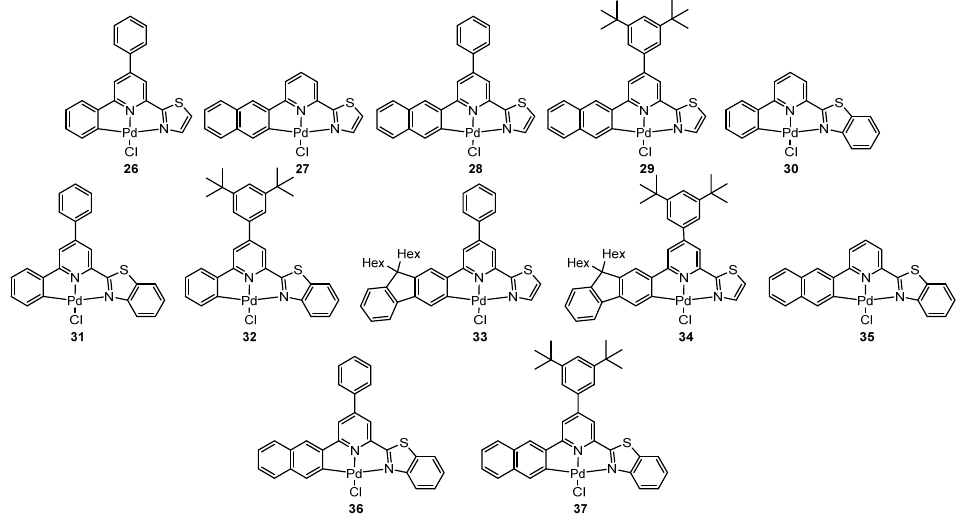
Figure 10. Schematic representation of the [Pd(C^N^N)Cl] complexes 26–37 . Adapted from